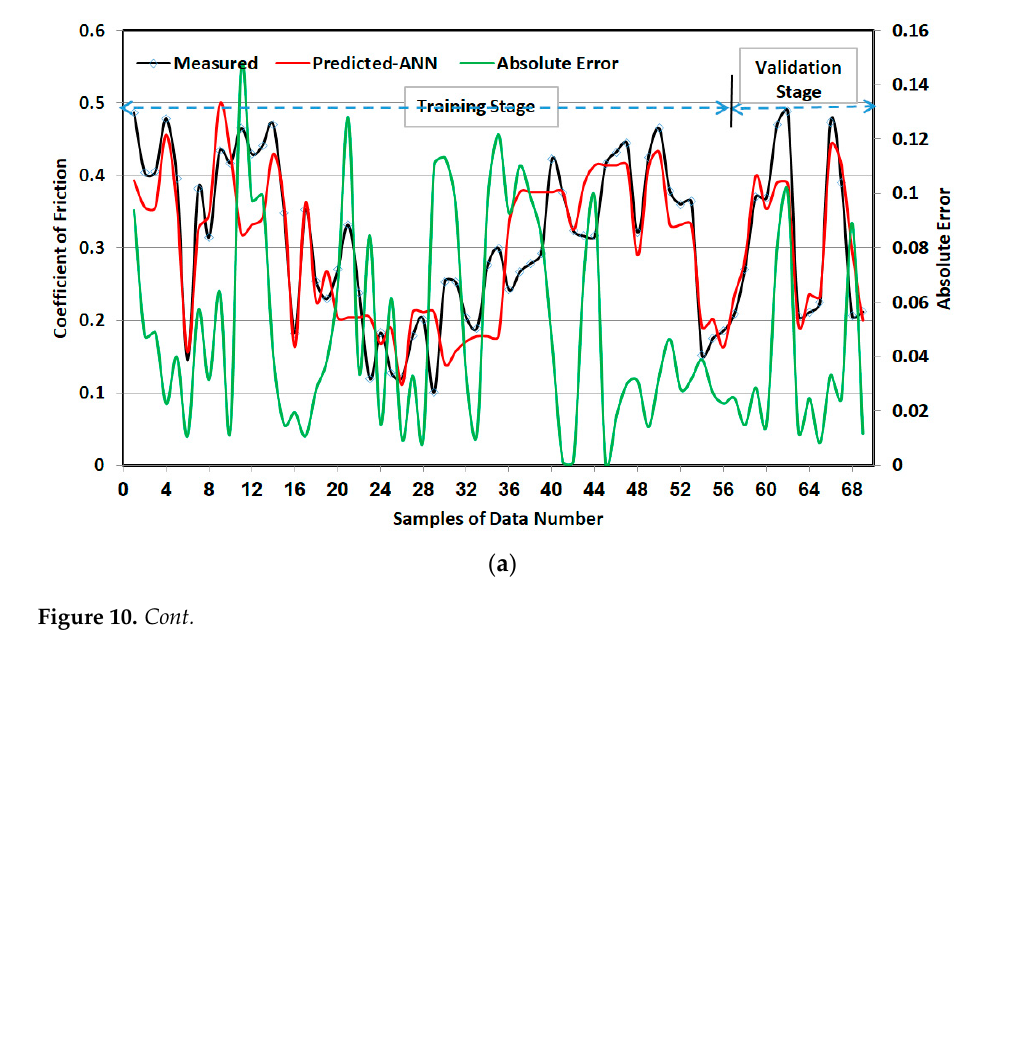
Figure 9. ANN model performance at the four stages for ( a ) single ( b ) double hidden layer.